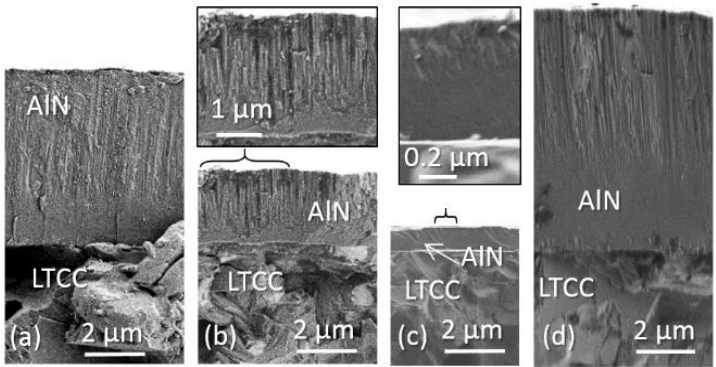
Figure 8. SEM micrographs of layers deposited with N 2 /Ar ratio of 10% on LTCC: ( a ) #3; ( b ) #4; ( c ) #8; ( d ) #10.